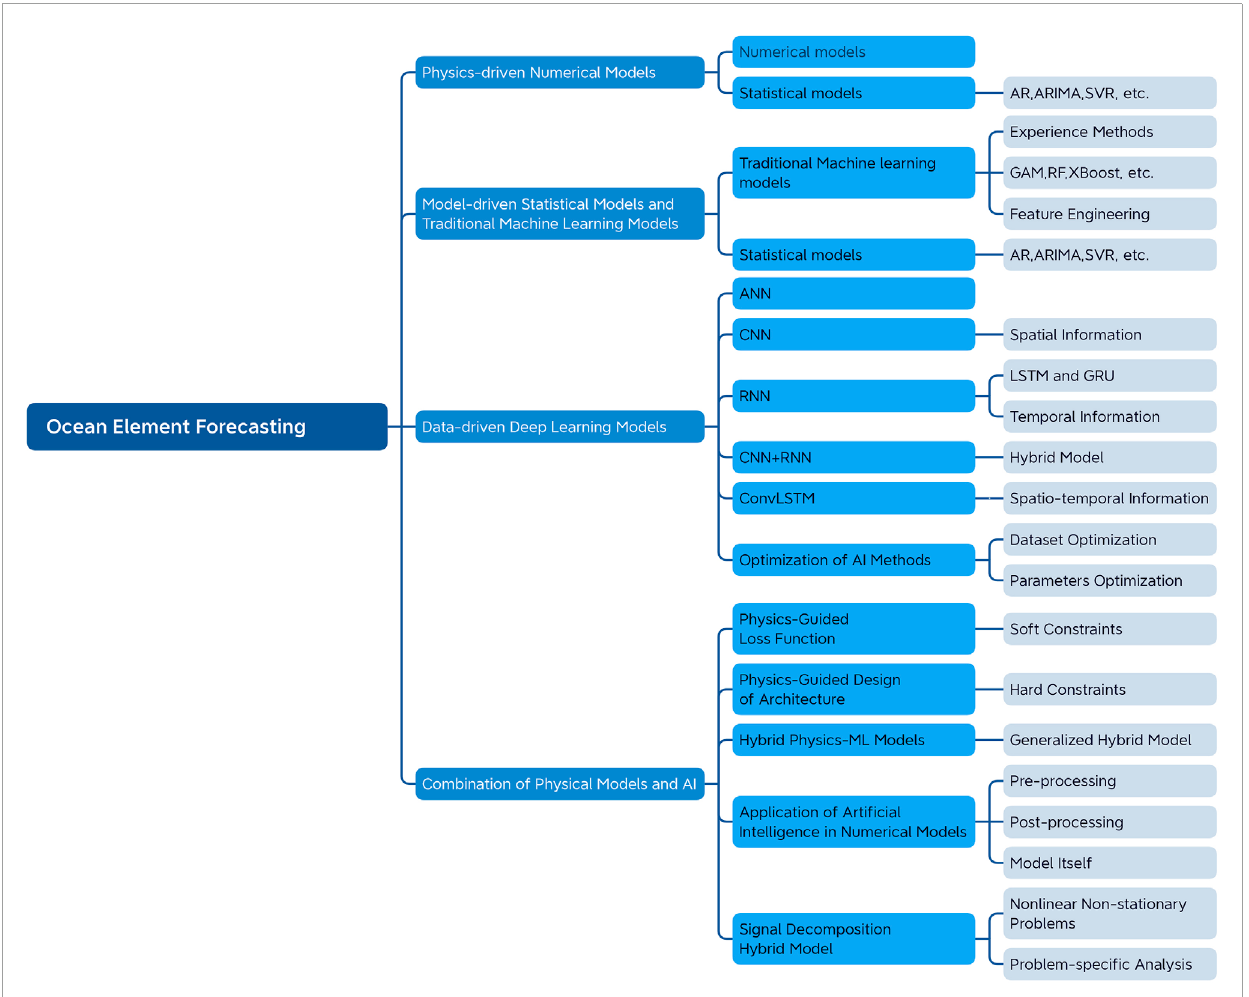
FIGURE 6 Ocean element forecasting. Four components comprise the AI approach to ocean element forecasting: physics-guided numerical models, model-guided statistical and traditional machine learning models, data-guided deep learning models, and the combination of physical models and AI. Each section describes the most prevalent model algorithms and model optimization techniques in the area of ocean element